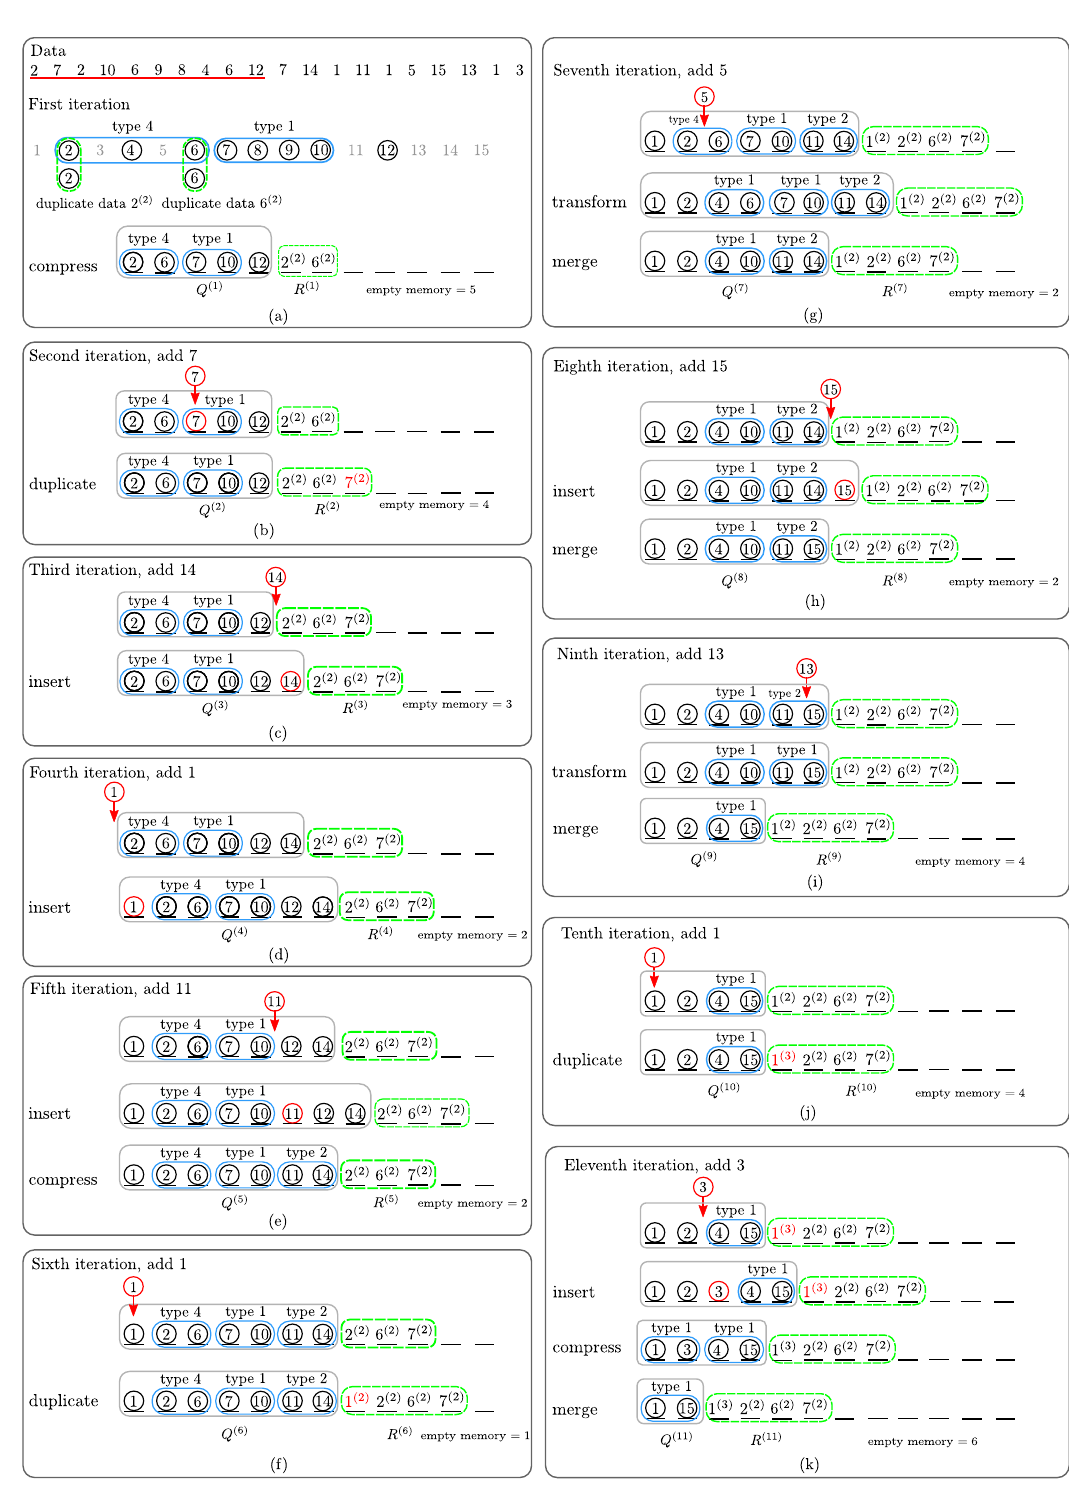
Fig 2. An example fast streaming data sort with 11 iterations from (a) to (k).